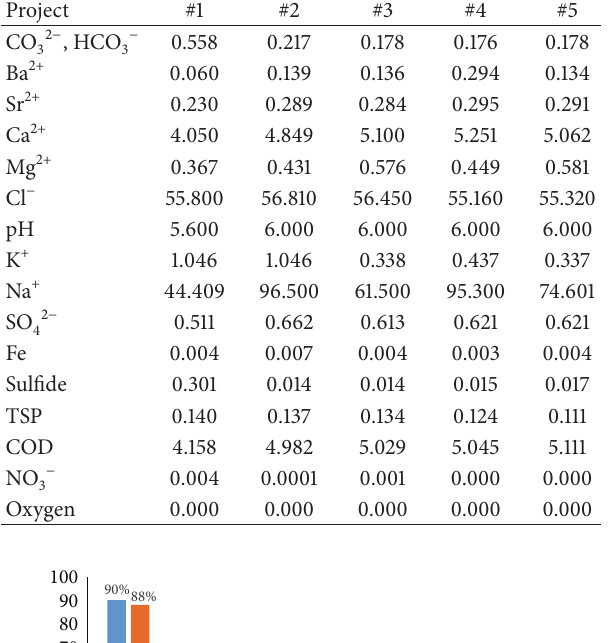
Table 1: Water inorganic ion analysis method.